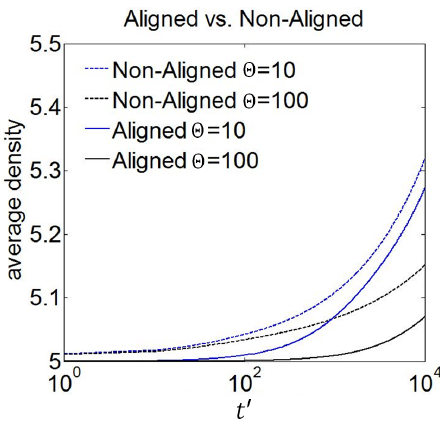
Figure 14. Evolution of average density due to diffusion for the low density region of the domain (marked in blue in Figure 13) at t (cid:48) = 0 for simulations performed in Cartesian and MFAM meshes for two different Θ